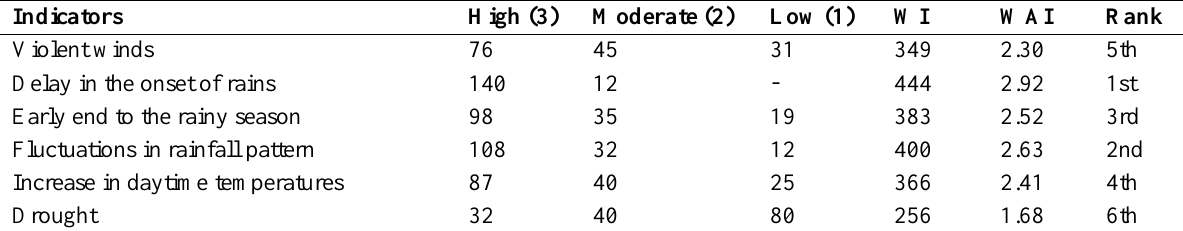
Table 3: Indicators of climate change perceived by respondents (n = 152).